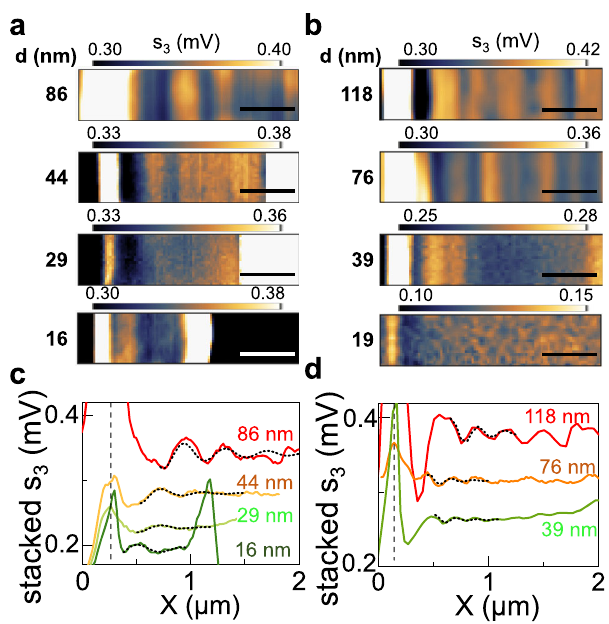
Fig. 4 Real-space mapping of propagating excitations. a , b Near- fi eld scattering maps of s 3 acquired at 66.7 cm − 1 at the edge of Bi 2 Se 3 ( a ) and Bi 2 Te 2.2 Se 0.8 ( b ) fl akes, with different thicknesses d, indicated on the side. The scale bar corresponds to 500 nm. c , d Line pro fi les (colored solid lines) extracted averaging the maps in panels a , b vertically on the displayed window, showing signal oscillations as a function of the position X on fl akes of Bi 2 Se 3 ( c ) and Bi 2 Te 2.2 Se 0.8 ( d ). The line pro fi le corresponding to the map of the 19-nm-thick fl ake of Bi 2 Te 2.2 Se 0.8 is not reported because it lacks evident periodicity. The line pro fi les are aligned to have the highest peak at the same position, which is identi fi ed by the black dashed vertical line. Fits of the oscillations to extract the periodicity, performed with the function described in the text, are plotted as short-dot black 2DEG, as a consequence of the band bending at the Bi 2 Se 3 interface with adjacent materials 36 .